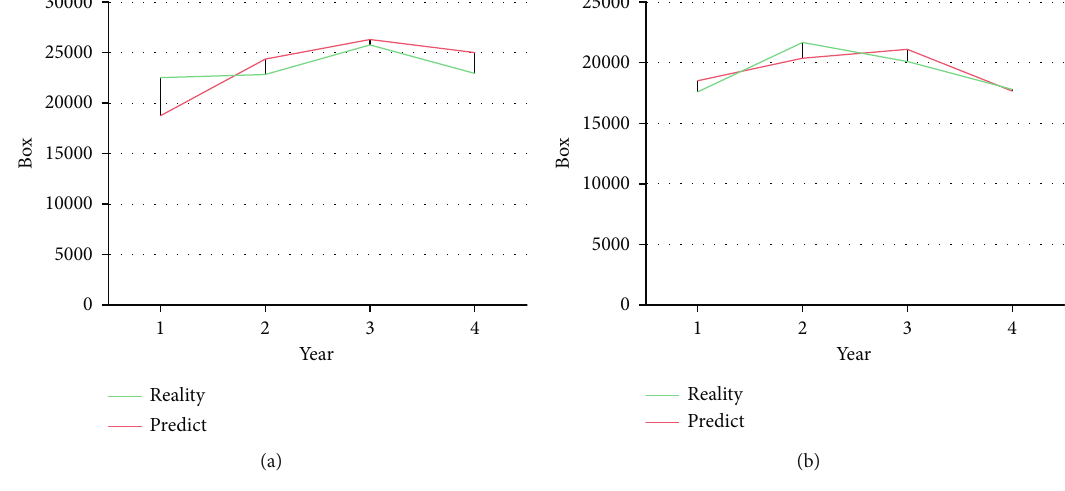
Figure 5: Actual and predicted results.